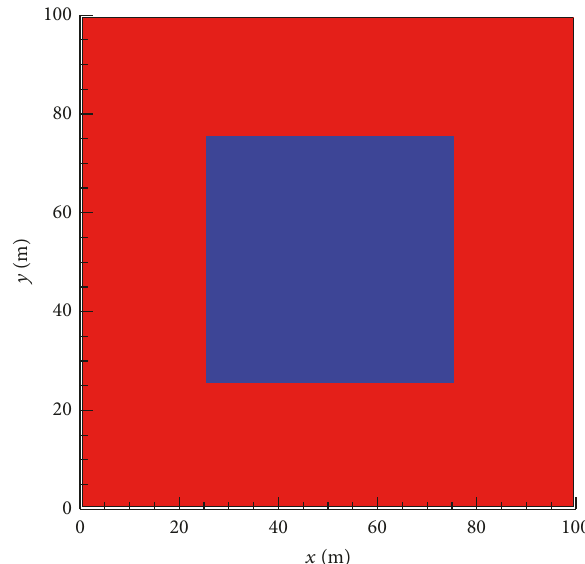
Figure 1: Computational domain and permeability.